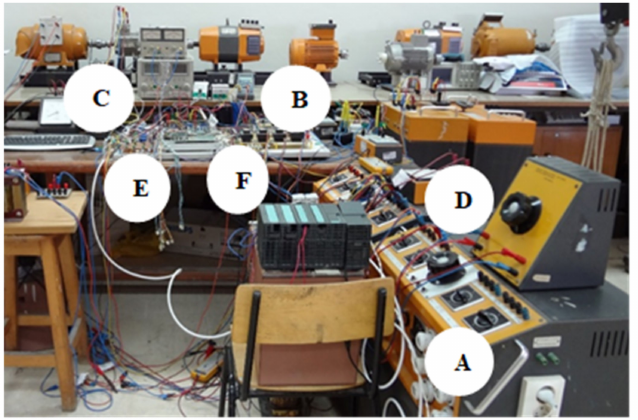
Figure 12. Photograph of the experimental prototype: ( A ) coupling transformer; ( B ) power converters; ( C ) prime mover and PMSG; ( D ) grid side and filter; ( E ) voltage and current transducer boards; ( F ) DSP Tri-core